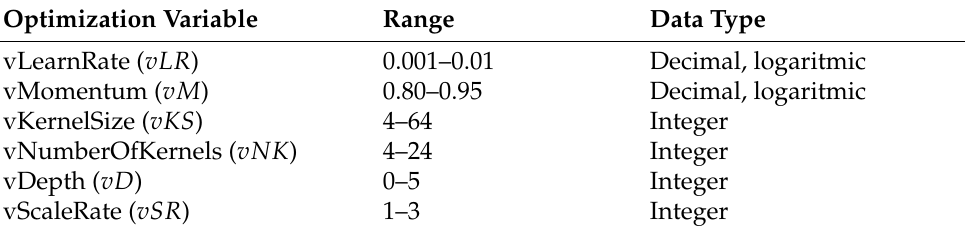
Table 2. Ranges of optimization variables for Bayesian optimization.